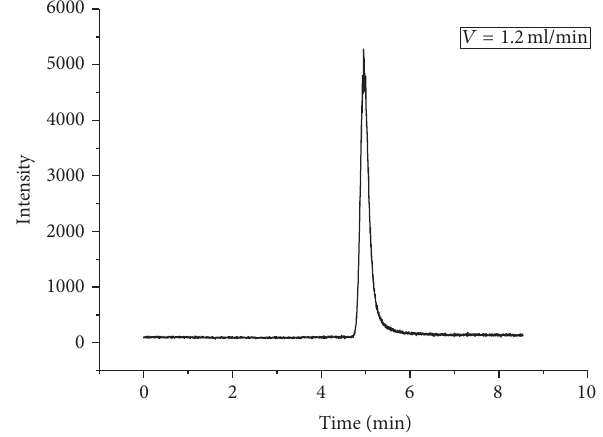
Figure 1: HPLC-ICP-MS spectrum for TBT standard substance (flow rate 1.2